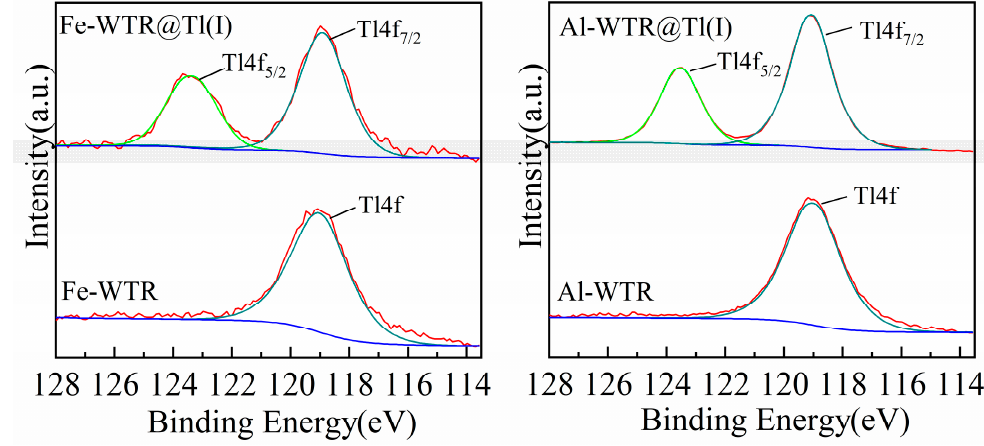
Figure 10. Tl 4f spectra of Al-WTR and Fe-WTR before and after adsorption.